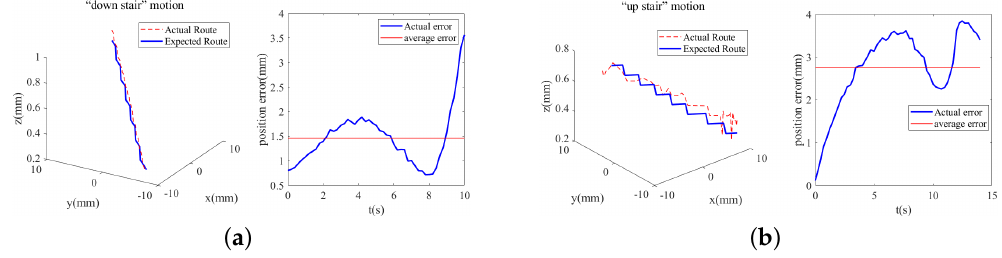
Figure 9. Demonstration of displacement control. ( a ) The milli/microrobot moves from the upper-right corner of the workspace along with the XOY projection to the lower-left corner while descending stepwise in the Z -axis direction. Average trajectory-completion time: 10.83 s. ( b ) The milli/microrobot moves from the lower-right corner of the workspace along with the XOY projection to the upper-left corner while rising stepwise in the Z -axis direction. Average trajectory-completion time: 14.4 s. The left figures are trajectories in the 3D workspace. The right figures show the errors between actual and desired